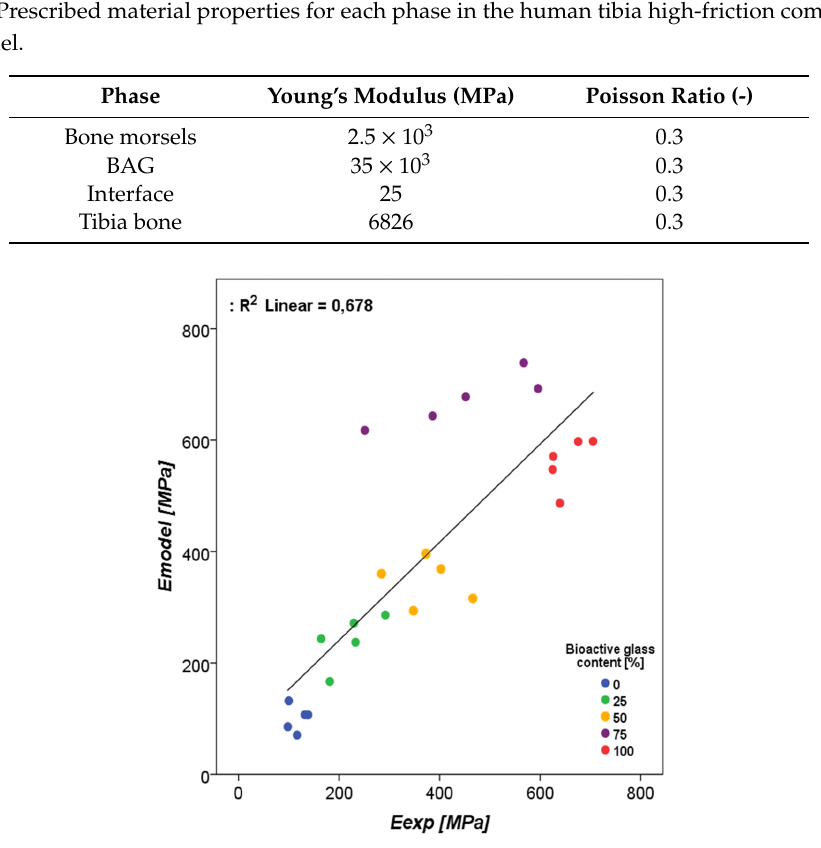
Figure 8. The regression of the experimental compression moduli as measured by Hulsen et al. (2016) [11] vs. the estimated compression moduli for the materials with increasing bioactive glass contents. Table 5. Prescribed material properties for each phase in the human tibia high-friction compression (FE) model.